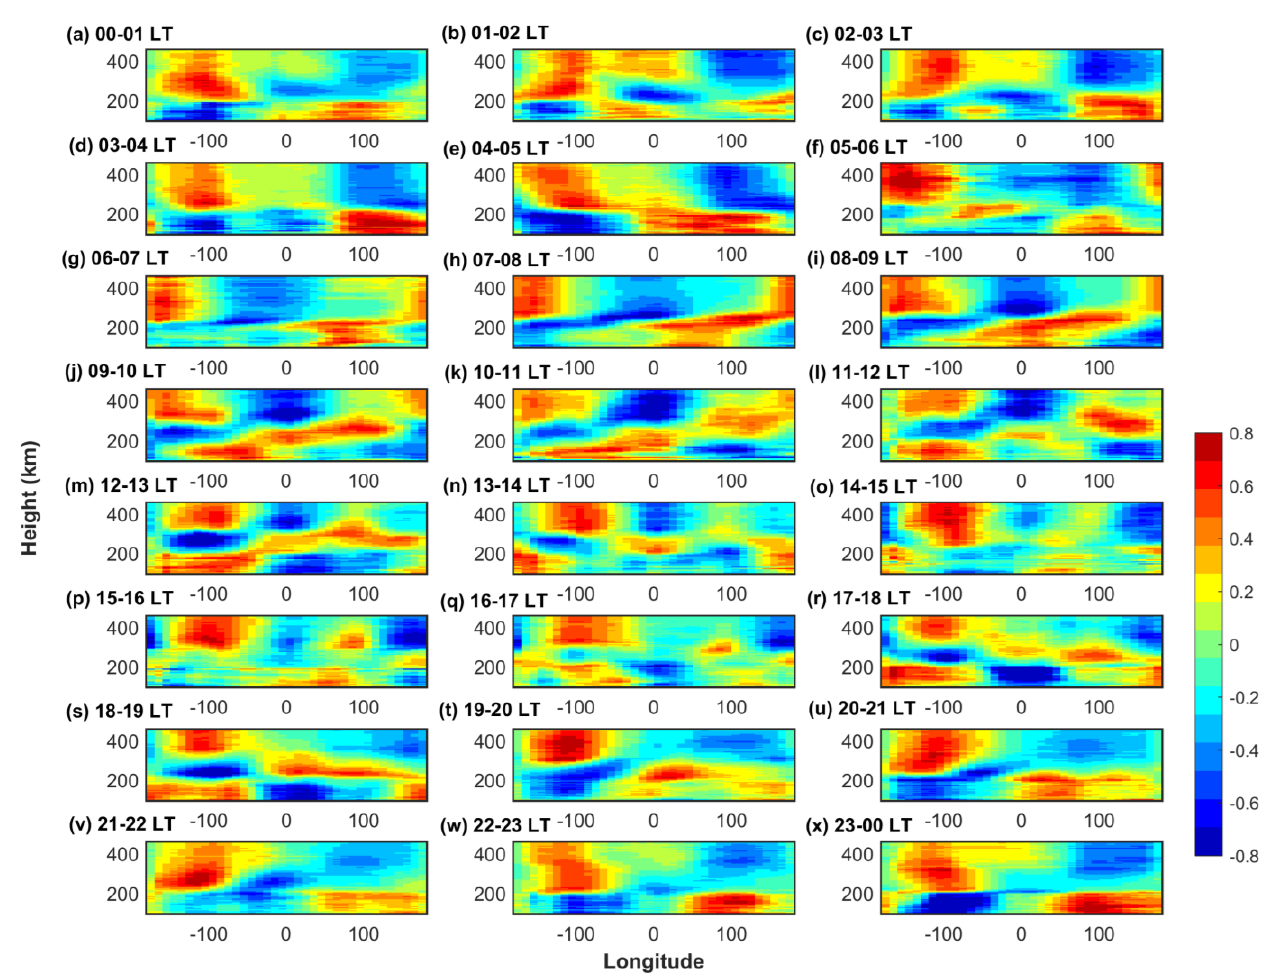
Figure 4. Hourly maps of altitude–longitude variation of WN4-filtered (residual) component of normalized electron density for September 2020. Panels ( a – x ) represent hourly epoch from 00–01 LT to 23–00